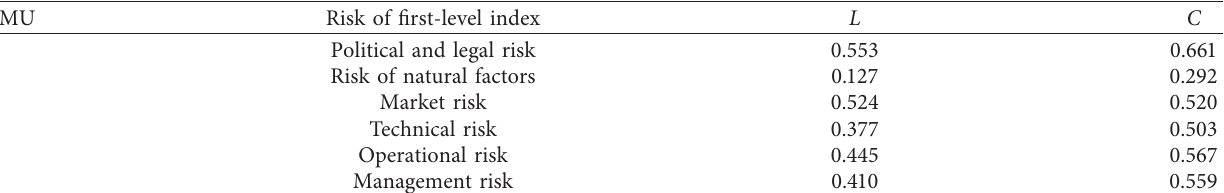
Table 3: Risk value of the first-level index